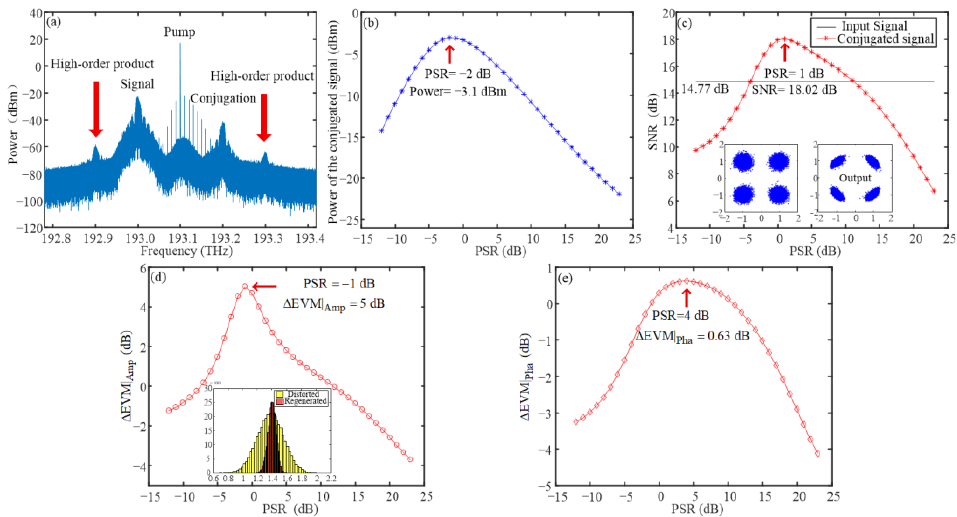
Figure 3. ( a ) Optical spectrum obtained in the XF case; ( b ) power response of the conjugated signal with the input PSR; ( c ) signal quality of the conjugated results with the PSR; ( d ) the amplitude EVM gain ΔEVM| Amp; and ( e ) the phase EVM gain ΔEVM| Pha on the input PSR.